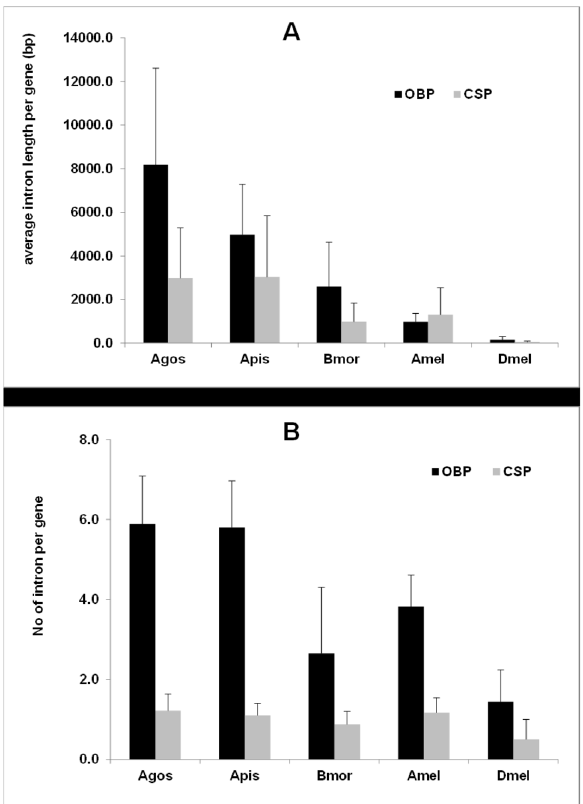
Figure 5. Introns in OBP and CSP genes. (A) intron number, (B) intron length. Agos: Aphis gossypii . Apis: Acyrthosiphon pisum . Bmor: Bombyx mori . Amel: Apis mellifera . Dmel: Drosophila melanogaster .